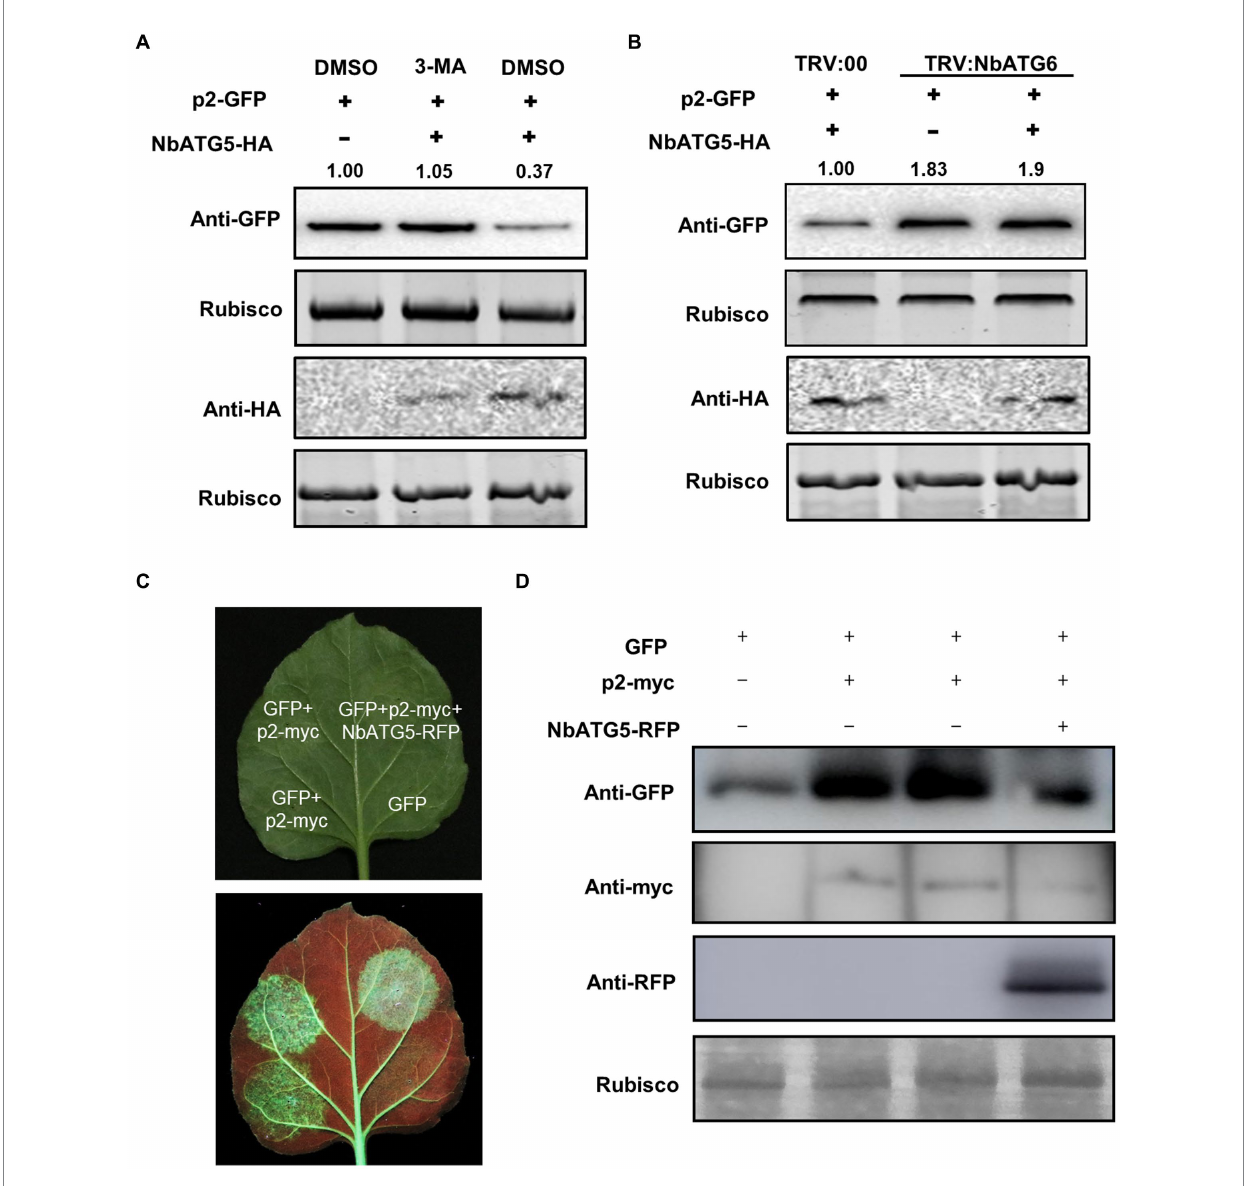
FIGURE 3 Overexpression of NbATG5 promotes the autophagic degradation of p2. (A) Overexpression of NbATG5 reduced the accumulation of p2, while treatment with the autophagy inhibitor 3-MA rescued such reduction. Total proteins were isolated from plant leaves agroinfiltrated with p2-GFP, with empty vector or with NbATG5-HA followed by DMSO or 3-MA treatment. Rubisco large subunit was used as a loading control. The relative level of p2-GFP was calculated by setting control (DMSO) values to 1.0 by ImageJ. (B) Silencing of NbATG6 inhibited NbATG5-mediated degradation of p2-GFP. Plants inoculated with TRV:00 or TRV-Nb ATG6 at 14 dpi were infiltrated with p2-GFP alone or with NbATG5-HA. Total protein was extracted from infiltrated leaves at 60 hpi. Western blotting assay of the sample protein used anti-GFP or HA. Rubisco large subunit was used as a loading control. The relative level of p2-GFP was calculated by setting the control (TRV:00) values to 1.0 by ImageJ. (C,D) Activity of p2 as suppressor of RNA silencing was impaired by overexpression of NbATG5 in N. benthamiana 16c plants. GFP fluorescence was revealed by UV illumination at 6 days post infiltration with Agrobacterium constructs (C) . Immunoblot analysis of protein expression using anti-myc, anti-RFP or anti-GFP antibodies (D) . Rubisco large subunit was used as a loading